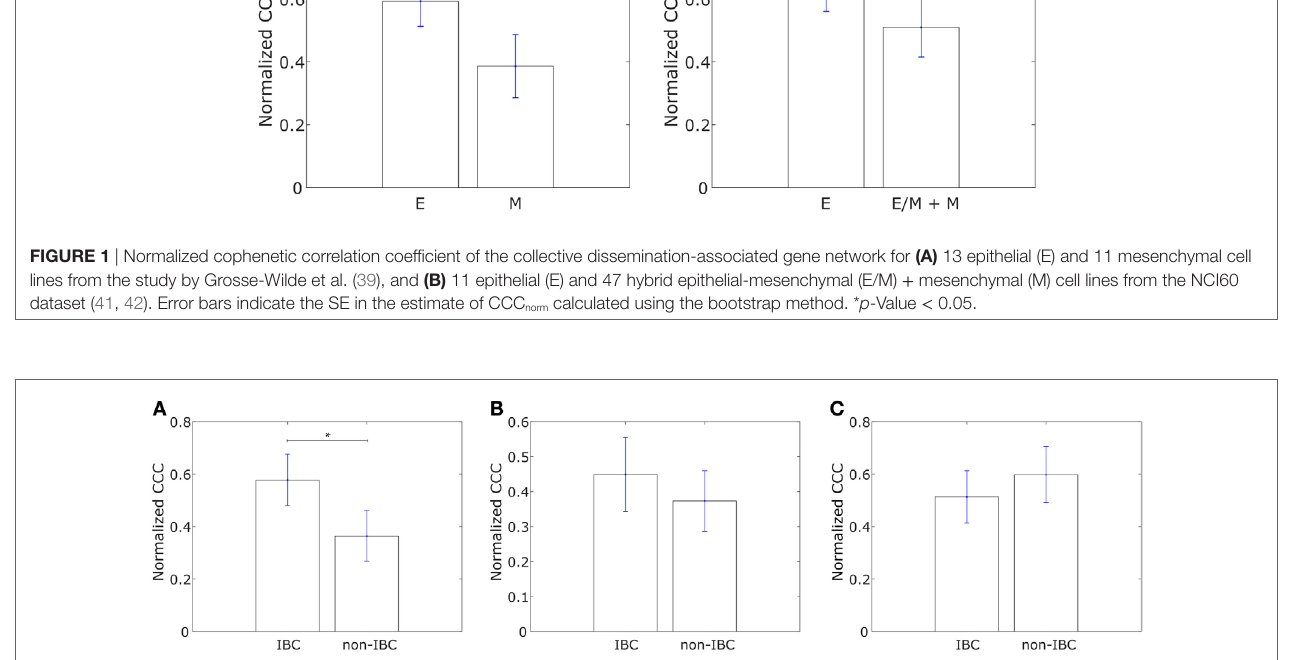
FigUre 2 | Normalized cophenetic correlation coefficient of the collective dissemination-associated gene network for tumor samples from inflammatory breast cancer (IBC) patients and non-IBC breast cancer patients for data from studies by (a) Iwamoto et al. (45) with 25 IBC and 57 non-IBC breast cancer patients, (B) Boersma et al. (46) with 13 IBC and 35 non-IBC breast cancer patients, and (c) Woodward et al. (24) with 20 IBC and 20 non-IBC breast cancer patients. Error bars indicate the SE in the estimate of CCC norm calculated using the bootstrap method. * p -Value <